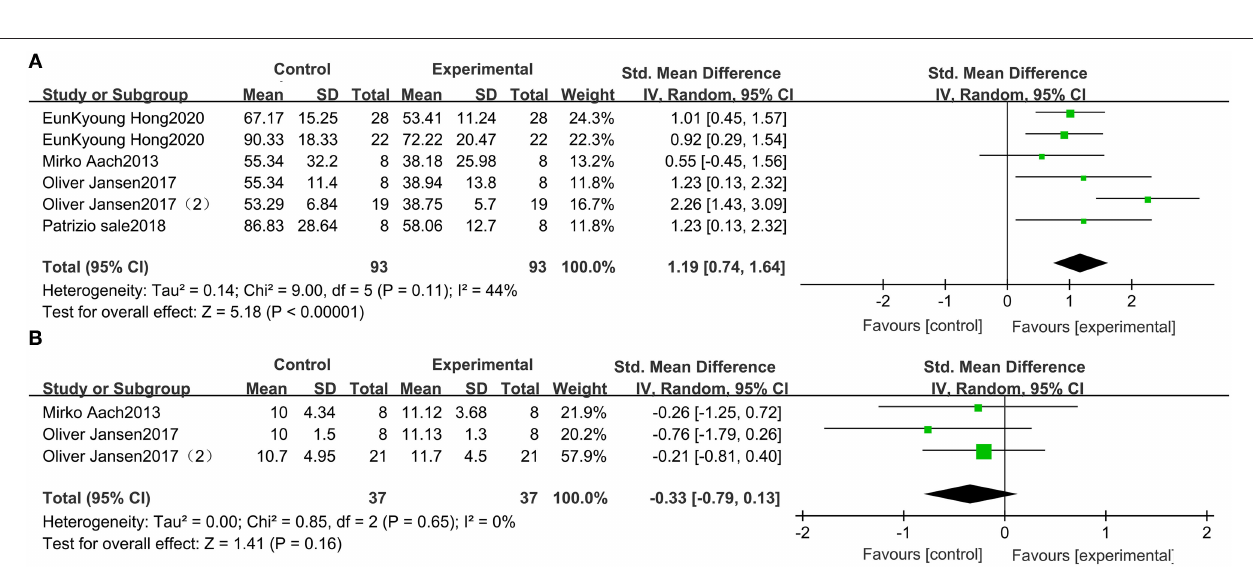
FIGURE 4 | Change from baseline in TUG (A) and WISCI-II (B)